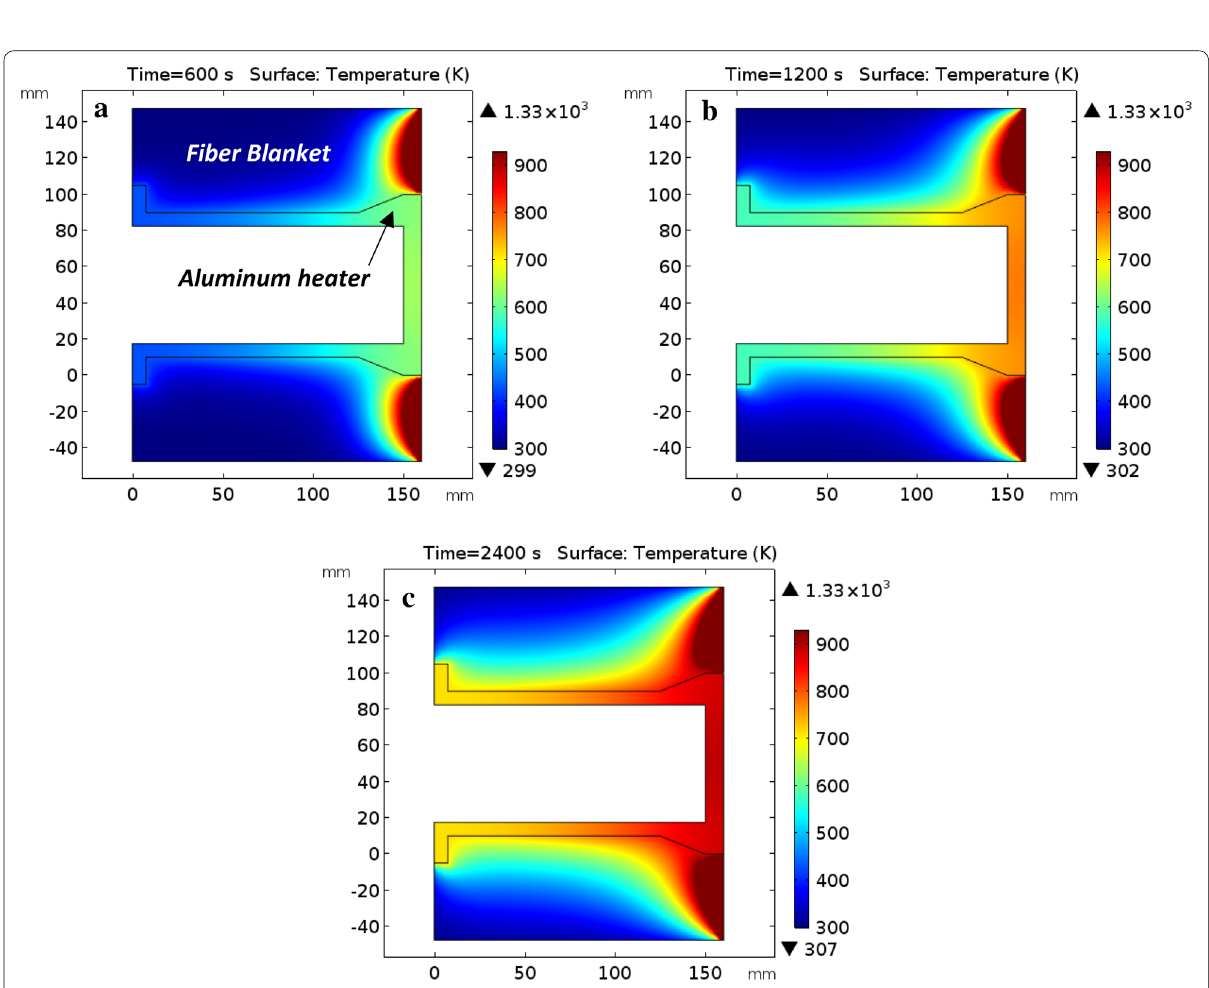
Fig. 13 Symmetrical heat maps of the longitudinal cut-plane across the center of the engine heater placed focally at a 600 s, b 1200 s and c 2400